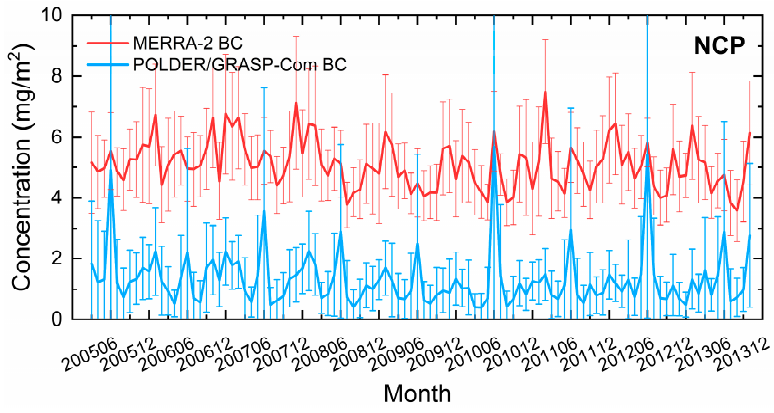
Figure 17. Same as Figure 13, but for North China Plain (NCP) region.